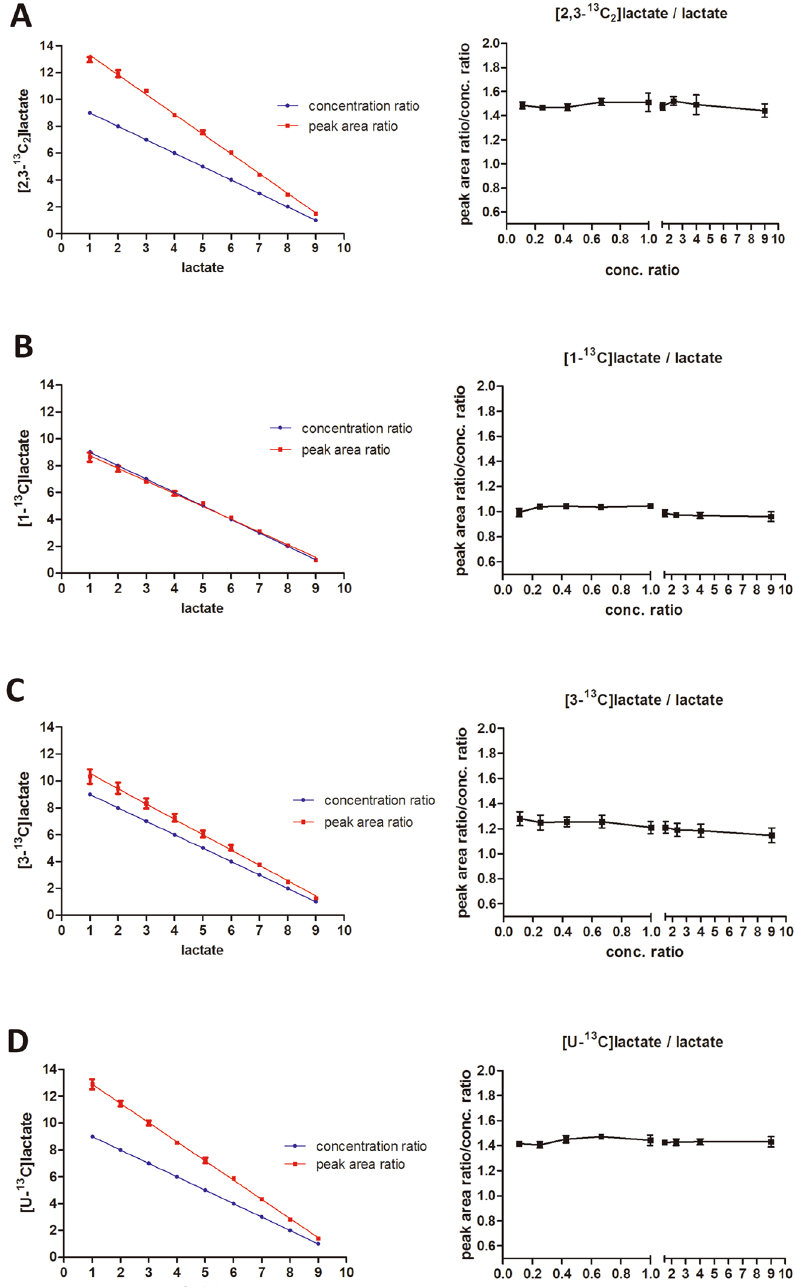
Figure 5. 13 C-labeling of lactate at different positions differentially influences its fragmentation efficiency under tandem mass spectrometry condition. ( A ) Left panel: standard mixture ([2,3- 13 C 2 ]lactate: lactate); red line: peak area ratios; blue line: concentration ratios. The mixtures were analyzed by LC-MS/MS under MRM mode in losing CO. [2,3- 13 C 2 ]lactate/lactate peak area ratio was 1.5 folds higher than [2,3- 13 C 2 ]lactate/lactate concentration ratio (right panel). Original data refers to Supplementary Table 11. ( B ) Left panel: standard mixture ([1- 13 C]lactate: lactate); red line: peak area ratios; blue line: concentration ratios. The mixtures were analyzed by LC-MS/MS under MRM mode in losing CO. [1- 13 C]lactate/lactate peak area ratio was comparable with [1- 13 C]lactate/lactate concentration ratio (right panel). Original data refers to Supplementary Table 12. ( C ) Left panel: standard mixture ([3- 13 C]lactate: lactate); red line: peak area ratios; blue line: concentration ratios. The mixtures were analyzed by LC-MS/MS under MRM mode in losing CO, [3- 13 C]lactate/lactate peak area ratio was 1.2 folds higher than [3- 13 C]lactate/lactate concentration ratio (right panel). Original data refers to Supplementary Table 13. ( D ) Left panel: standard mixture ([U- 13 C]lactate: lactate); red line: peak area ratios; blue line: concentration ratios. The mixtures were analyzed by LC-MS/MS under MRM mode in losing CO, [U- 13 C]lactate/lactate peak area ratio was 1.4 folds higher than [U- 13 C]lactate/lactate concentration ratio (right panel). Original data refers to Supplementary Table 14. The data represent mean ± SD, n = 6, and are confirmed by 2 independent